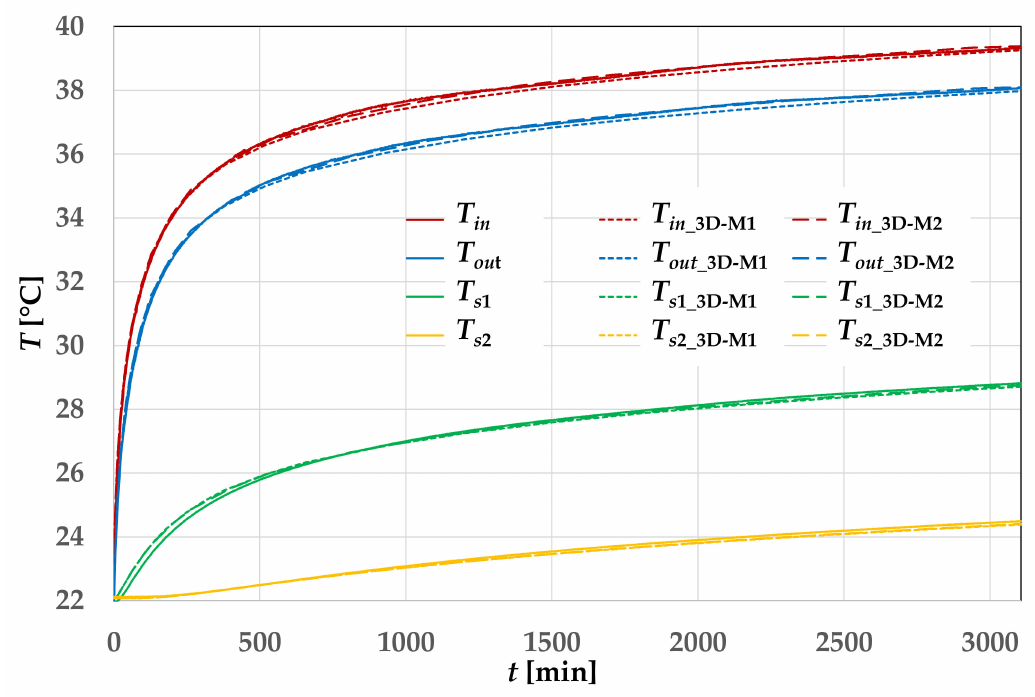
Figure 17. Time evolutions of T in , T out , T s 1 , T s 2 obtained experimentally, by 3D simulations with Mesh 1 (subscript 3D-M1), and by 3D simulations with Mesh 2 (subscript 3D-M2), for k g = 0.863 W/(mK), ( ρ c ) g = 4.6 MJ/(m 3 K), k s = 3.22 W/(mK), ( ρ c ) s = 3.0667 MJ/(m 3 K), and 8 L of external